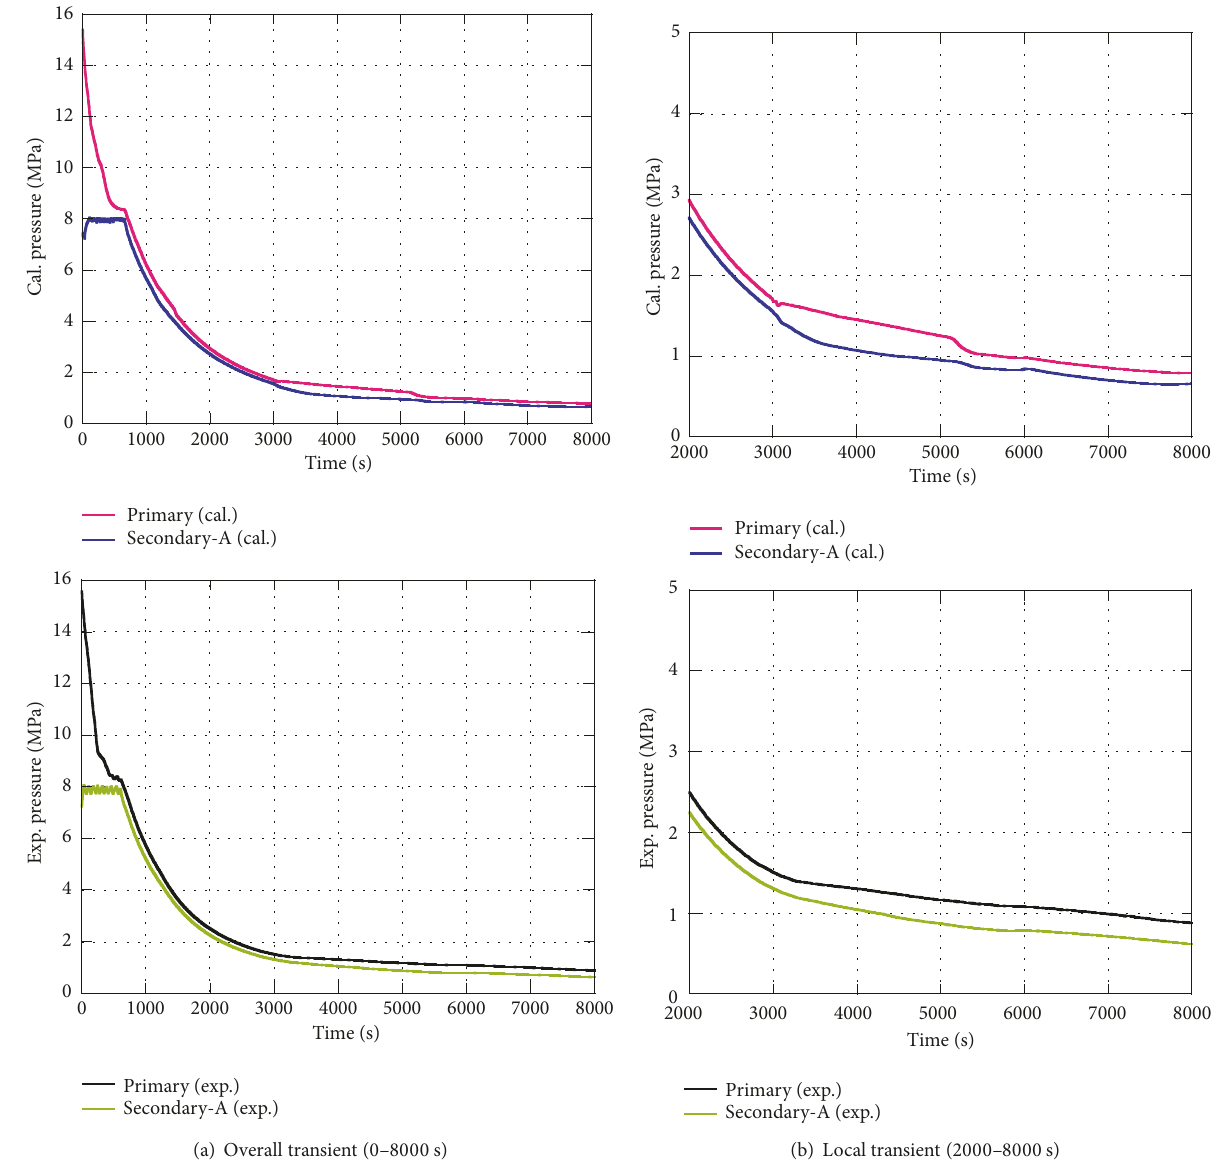
Figure 5: TR-LF-18 test and RELAP5 results for primary and SG secondary-side pressures in loop A.